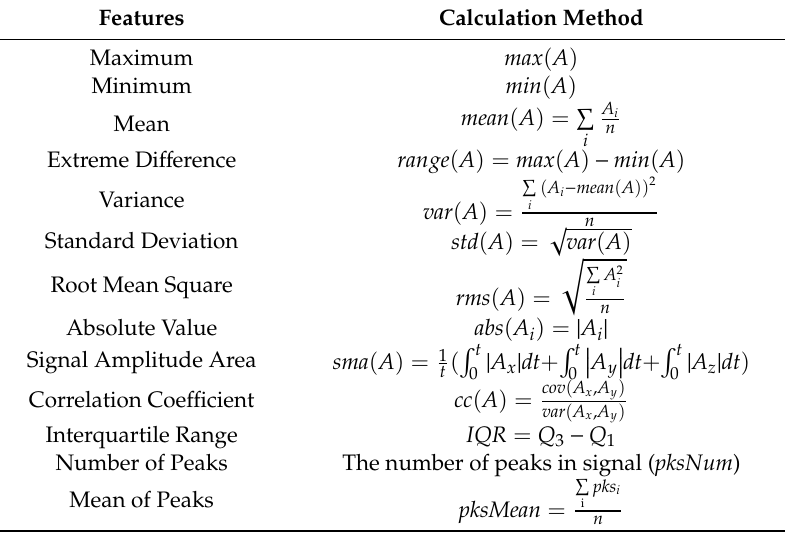
Table 1. The commonly used features and the calculation